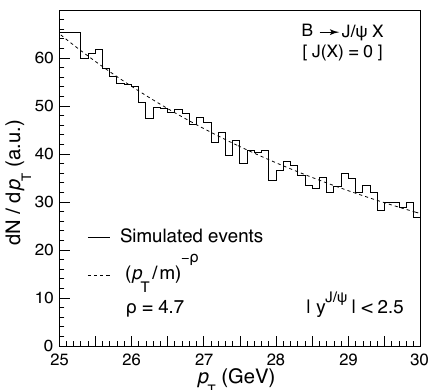
Figure 6 . The J /ψ p T distribution of simulated B → J /ψ X events with unobserved X , in the 25 < p J /ψ < 30 GeV range. T